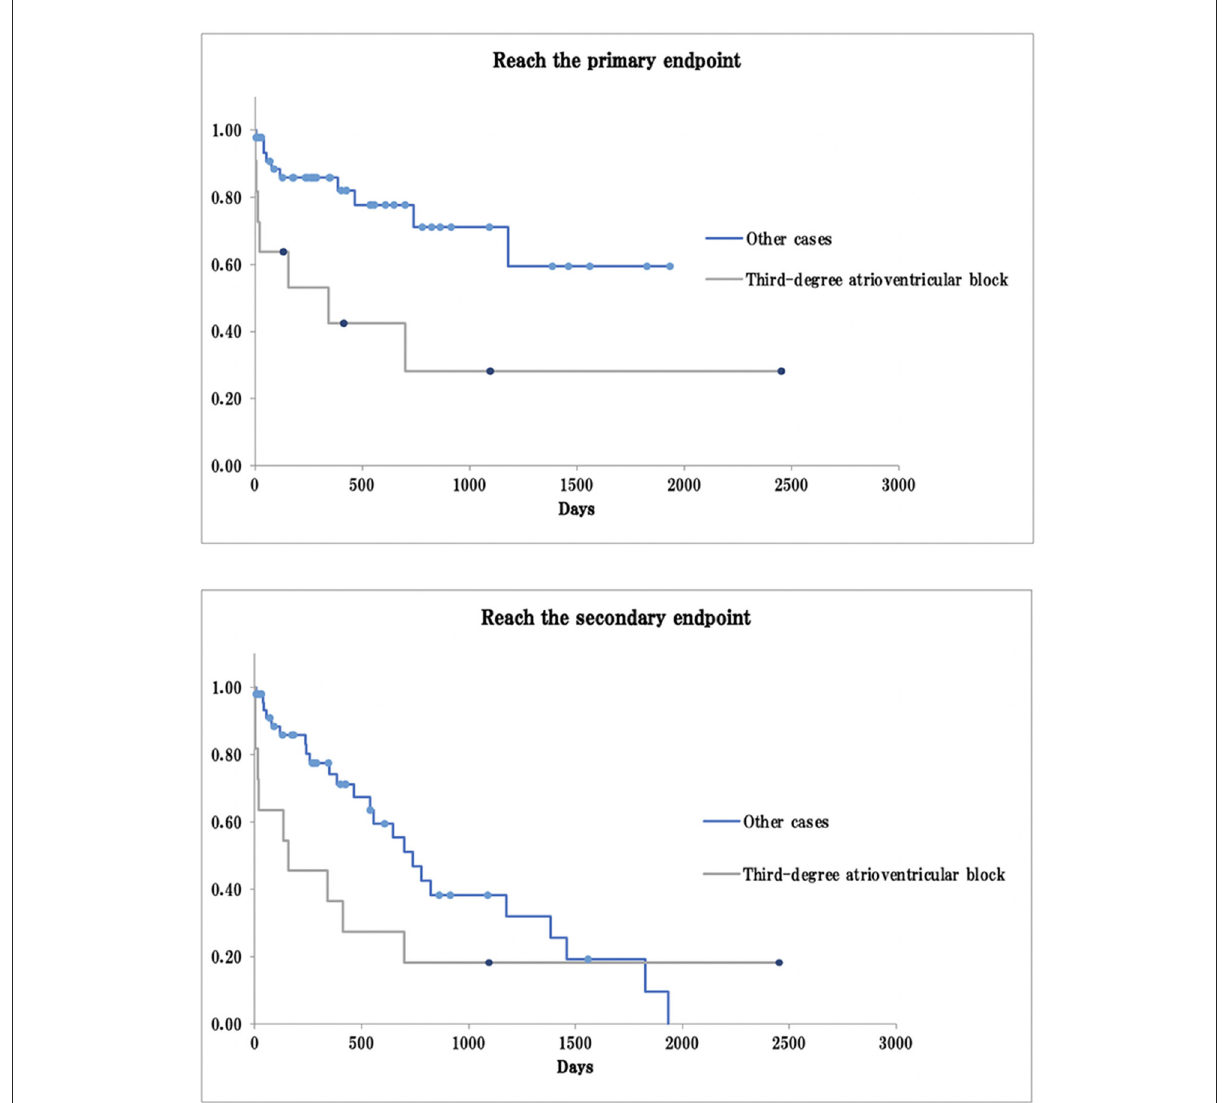
FIGURE1 Survival curve in third-degree atrioventricular block and other cases. The primary endpoint: arrhythmia-related death or PMI as a result of bradyarrhythmia that was not controlled by cilostazol; The secondary endpoint: death from any cause, including arrhythmia-related death or PMI; Dot: the data cut-off